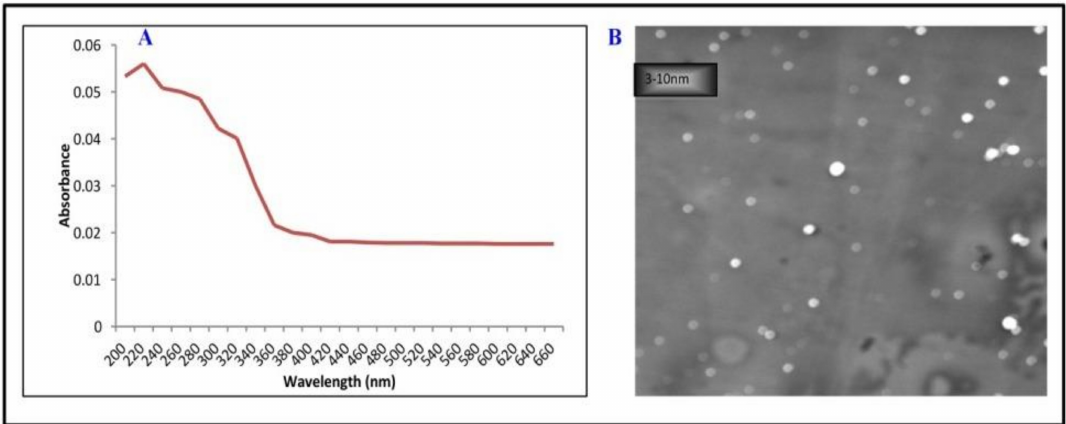
Figure 1. Physio-chemical characterization of synthesized carbon nanoparticles (CNPs) ( A ) UV-Vis Spectroscopy, ( B ) Scanning electron microscope (SEM) of CNPs with an average diameter of 6.5